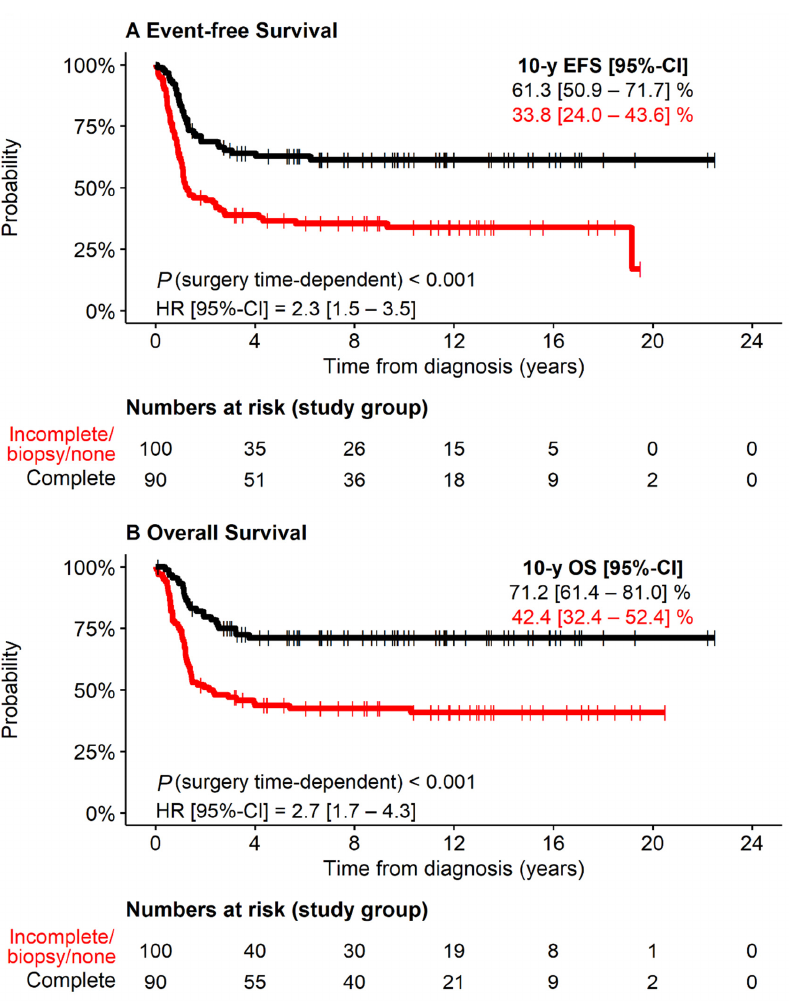
Figure 4. EFS and OS of 190 study group patients with MYCN amplification and stages 1, 2, 3, 4S or stage 4 aged <18 months by completeness of surgical resection *. * If more than one surgical intervention, the best result was counted. ( A ) Event-free Survival. ( B ) Overall survival. High-dose chemotherapy was associated with both better EFS and OS (likelihood ratios p < 0.001), while antibody therapy was not (likelihood ratio EFS p = 0.133; likelihood ratio OS p = 0.083). Intravenous systemic 131 mIBG radiotherapy and percutaneous